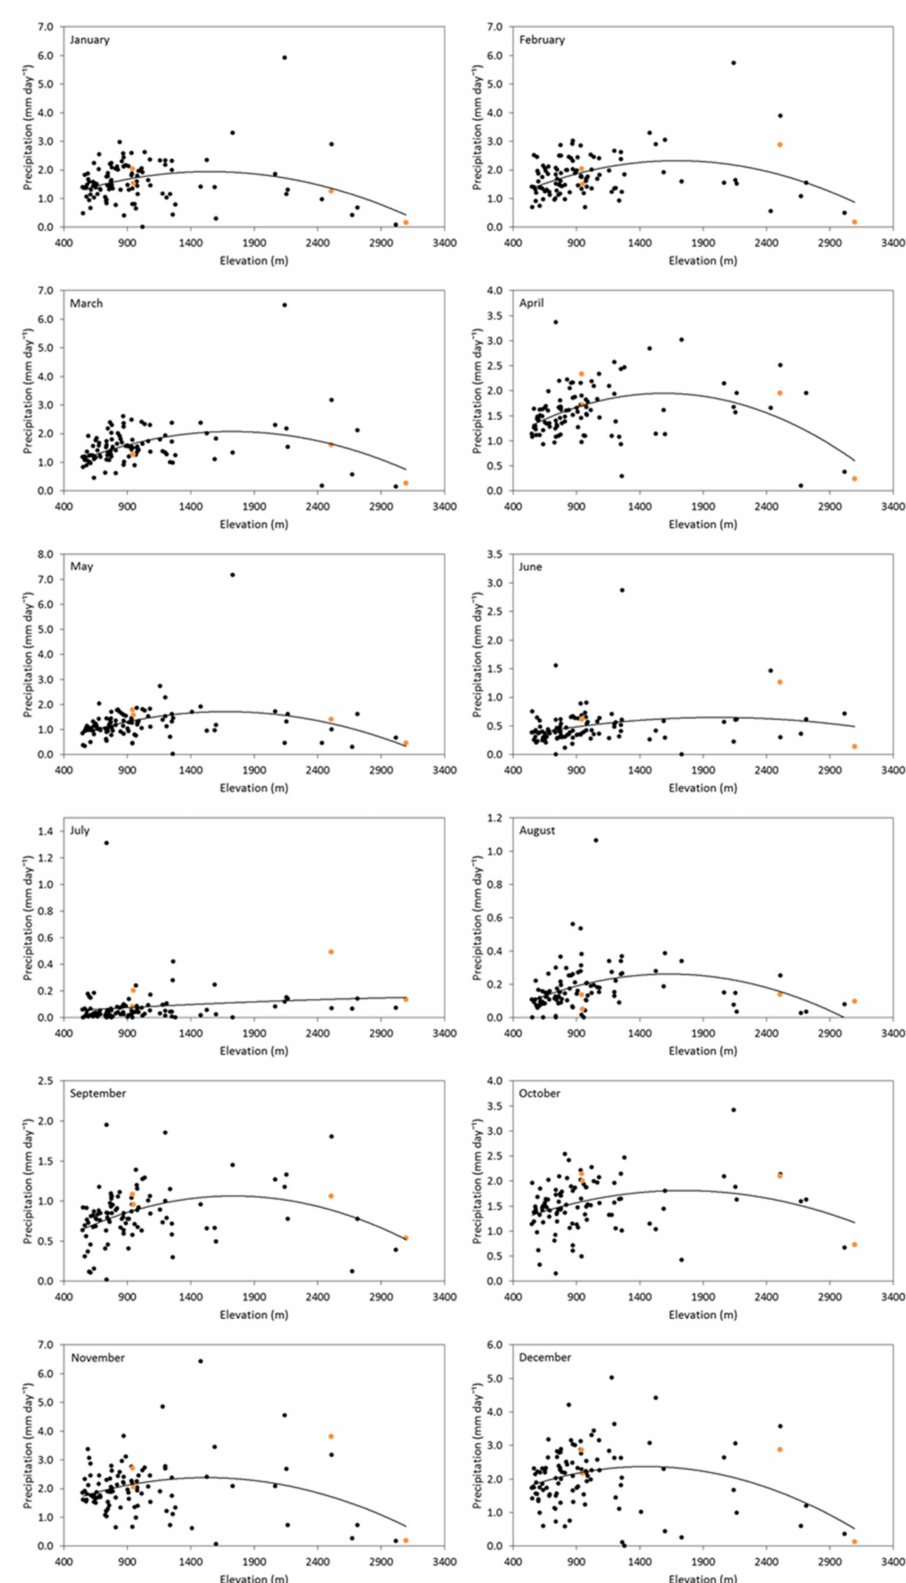
Figure 6. Trend of precipitation with elevation for the di ff erent months. Orange dots represent gauges included in the Canales